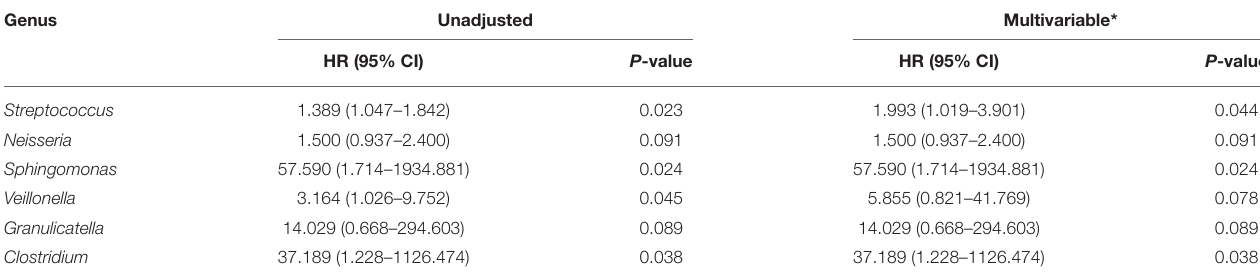
TABLE 3 | Risk factors for mortality in patients with IPF assessed using multivariable Cox proportional hazards models.